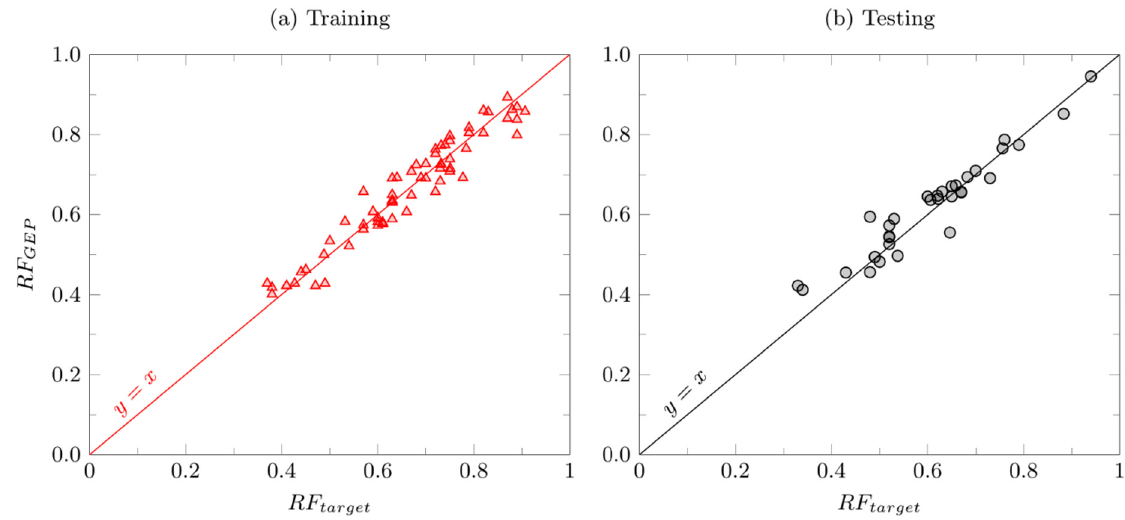
Figure 6. Cross plot of training data against the target values.